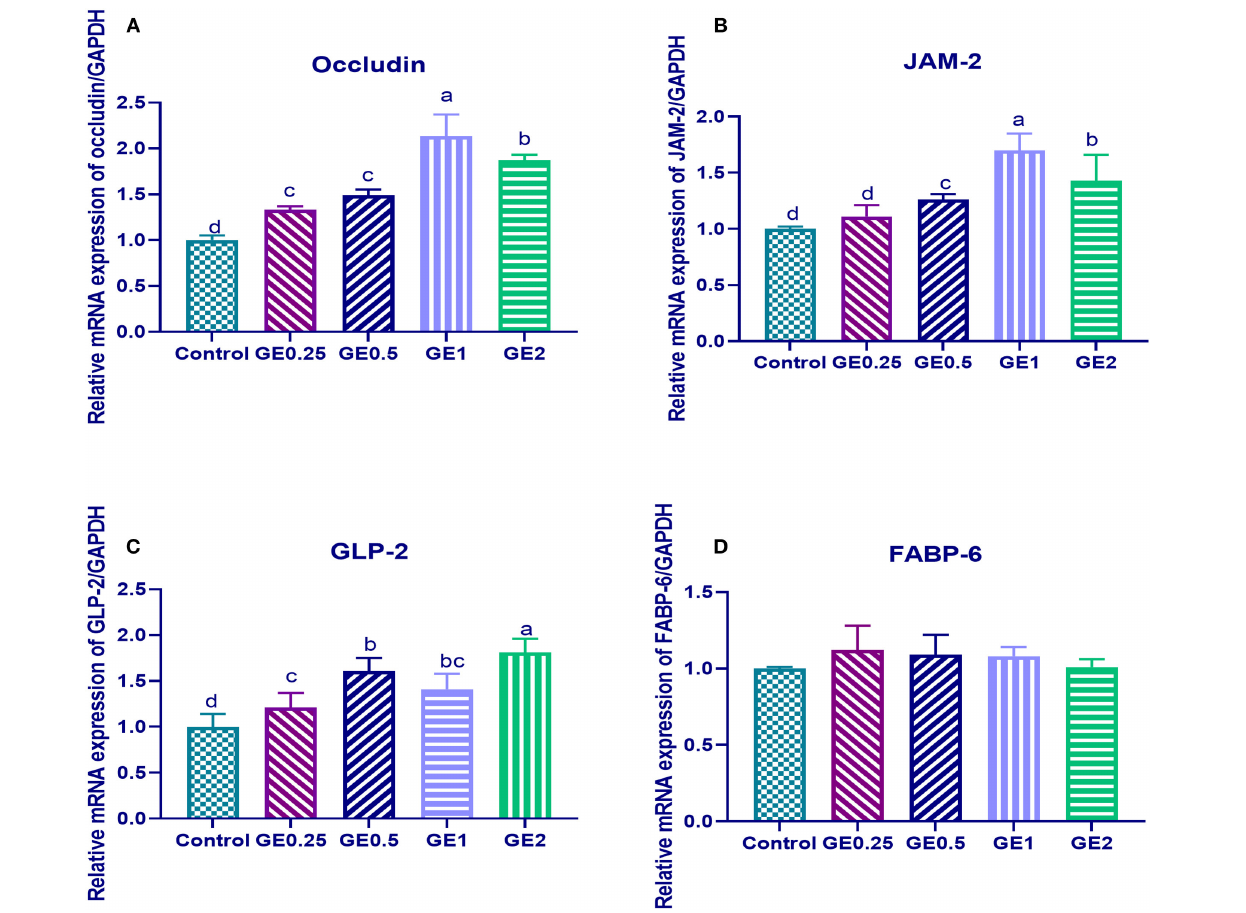
FIGURE 1 | Effects of dietary supplementation of Glycyrrhiza extract on genes coding tight junction protein expression [occludin and junctional adhesion molecules (JAM-2)] and gut protective genes (GLP-2, FABP-6). Control referred to basal diet. GE0.25, GE0.5, GE1, and GE2 referred to basal diet supplemented with 0.25, 0.5, 1, and 2 g/kg Glycyrrhiza extract, respectively. Data represent mean values from 10 independent experiments; error bars indicate SE, n = 10. (A) Occludin expression was significantly upregulated in all groups supplemented with GE compared with the control group ( P < 0.05). Occludin expression in GE0.25 and GE0.5 showing non-significant difference ( P < 0.05). (B) JAM-2 expression was significantly upregulated in all groups supplemented with GE compared with the control group ( P < 0.05) except for GE0.25 showing non-significant difference ( P < 0.05). (C) GLP-2 expression was significantly upregulated in all groups supplemented with GE compared with the control group ( P < 0.05). (D) FABP-6 expression in all groups supplemented with GE showing non-significant difference ( P < 0.05) compared with the control